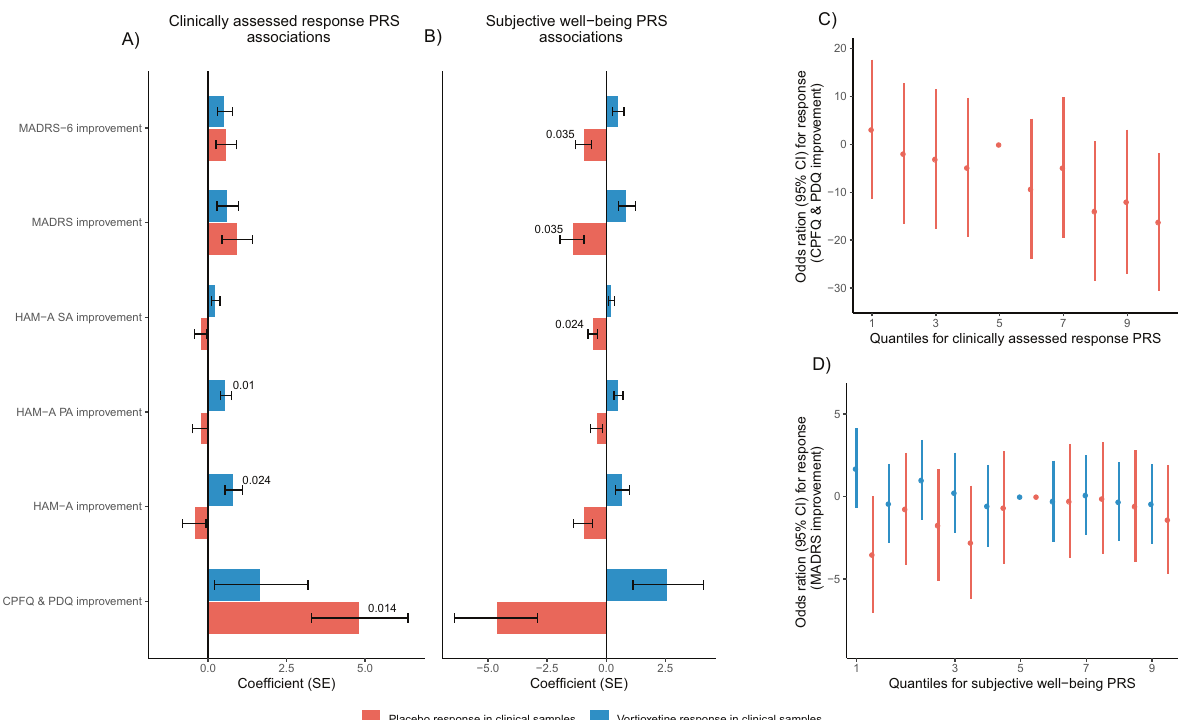
Fig. 4 Clinically assessed response and subjective well-being PRSs association with placebo response. Bar plot showing the coef fi cients for all placebo and vortioxetine response outcome measures in the clinical test sample association with A clinically assessed response PRS and B subjective well-being PRS. C Odds ratios for placebo response in the clinical test sample for clinically assessed response PRS. D Odds ratios for placebo response and vortioxetine response in the clinical test sample for subjective well-being